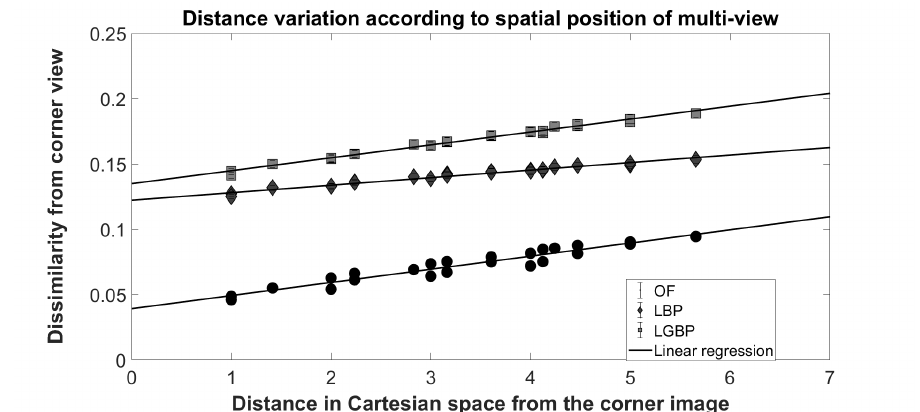
Figure 12. Relation between the distance of a pair of views in Cartesian space and the face recognition dissimilarity score: The observed linear correlation proves the feature extractor capability to capture the small face variation present in each view.